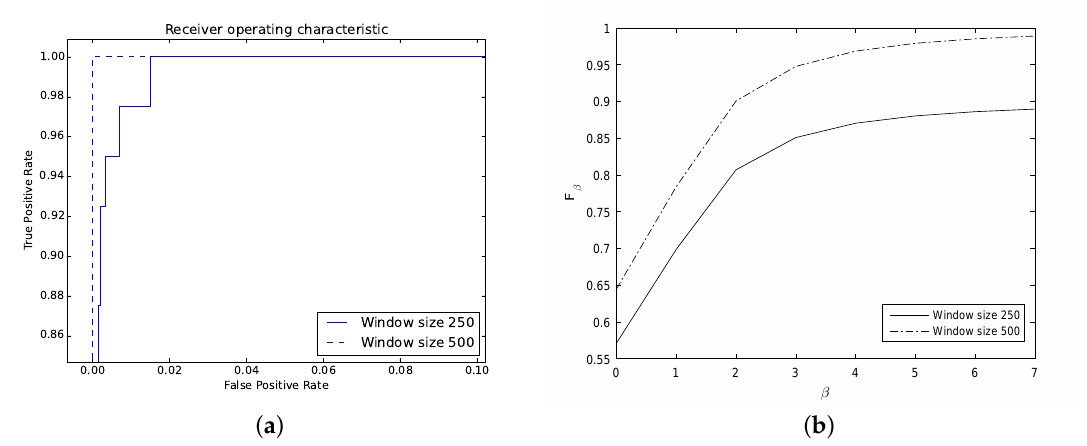
Figure 11. Resulting curves showing the classifier’s performance for the synthetic flood attack. ( a ) ROC curves for both windows, 250 and 500; ( b ) F β curves for both windows, 250 and 500.